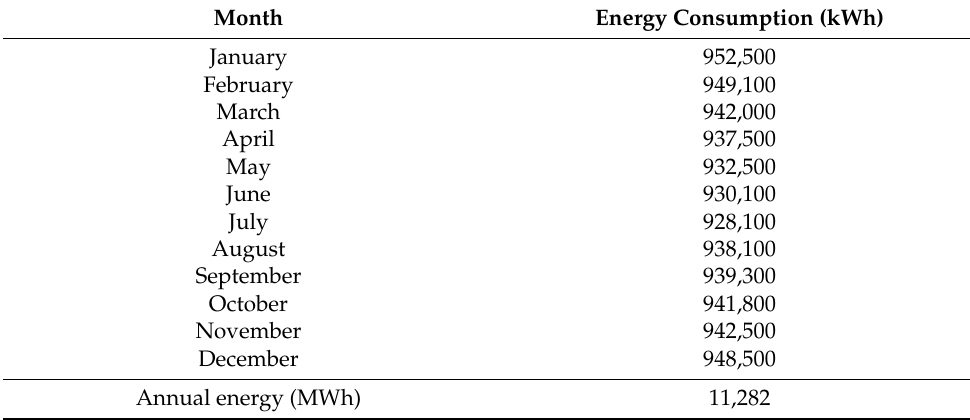
Table 1. Monthly and annual energy consumption of the